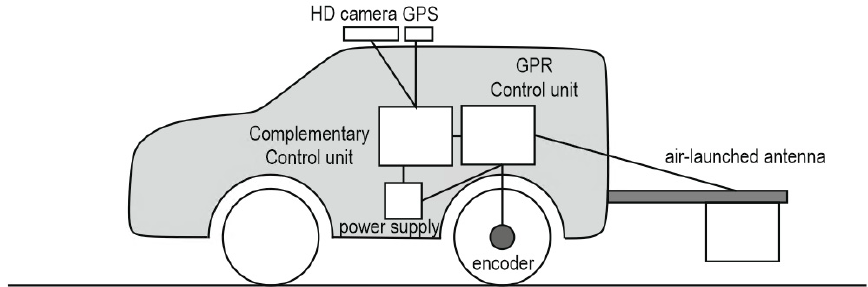
Figure 2. A typical GPR system configuration used for road inspections.